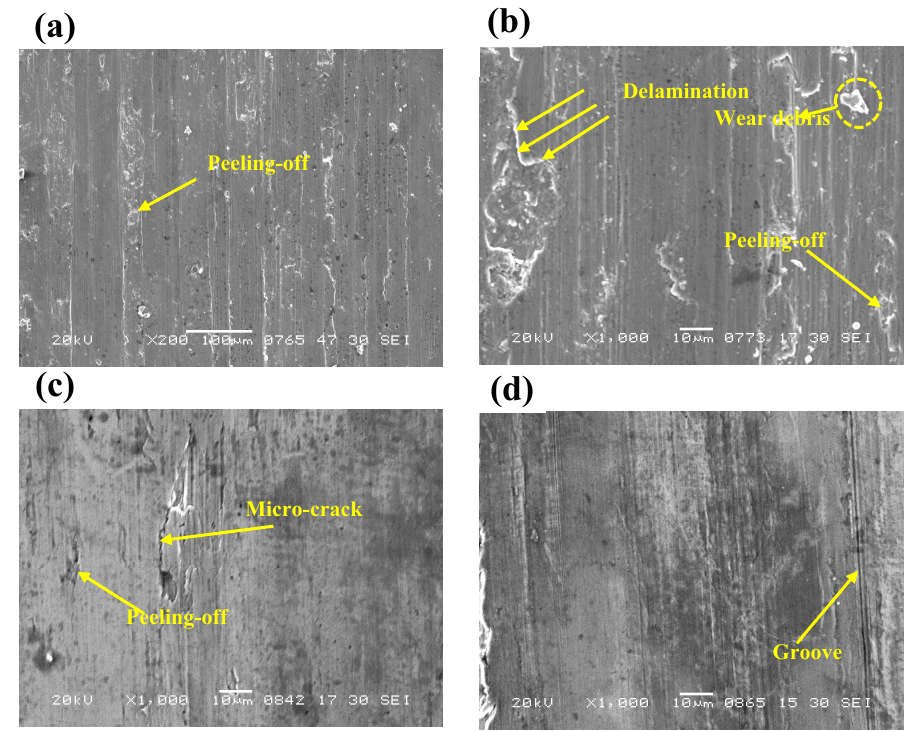
Figure 11. SEM morphologies of wear surfaces for ( a , b ) the substrate, ( c ) L1 and ( d ) L3. 4. Conclusions The single-layer and three-layer nickel-based coatings have been fabricated on 316L SS substrate by laser additive manufacturing and are metallurgically bonded well with the substrate without obvious defects. The microstructure, surface precipitates and wear resistance of the coatings have been systematically studied and the following conclusions have been drawn: (1) The XRD patterns of single-layer cladding and multilayer cladding coatings are similar, both including γ -(Fe, Ni) solid solution phase, Cr 5 B 3 , Ni 17 Si 3 , and Ni 3 B phases. Due to the diffusion of Fe, the content of γ -(Fe, Ni) solid solution in the surface of single-layer coating is higher than that of the multilayer coating. (2) Cellular crystals are observed in the coating-substrate interface of both single-layer cladding and multilayer cladding samples. With the change of G/R ratio, equiaxed dendrites appear in the middle of the single-layer coating, and columnar dendrites and steering crystals appear on the surface. However, due to heat accumulation, columnar dendrites with large size and different directions appear in the middle region of the multilayer cladded Ni-based coating. No obvious dendrite morphologies are observed in the surface area of the multilayer cladded coating, and the massively distributed Ni 17 Si 3 phases help to obtain a finer surface structure. (3) The surface microhardness of 316L SS has been significantly improved by Ni-based coating by about 2.5 times. The average microhardness of multilayer cladding coating is about 48 HV 0.2 higher than that of the single-layer cladding coating, and